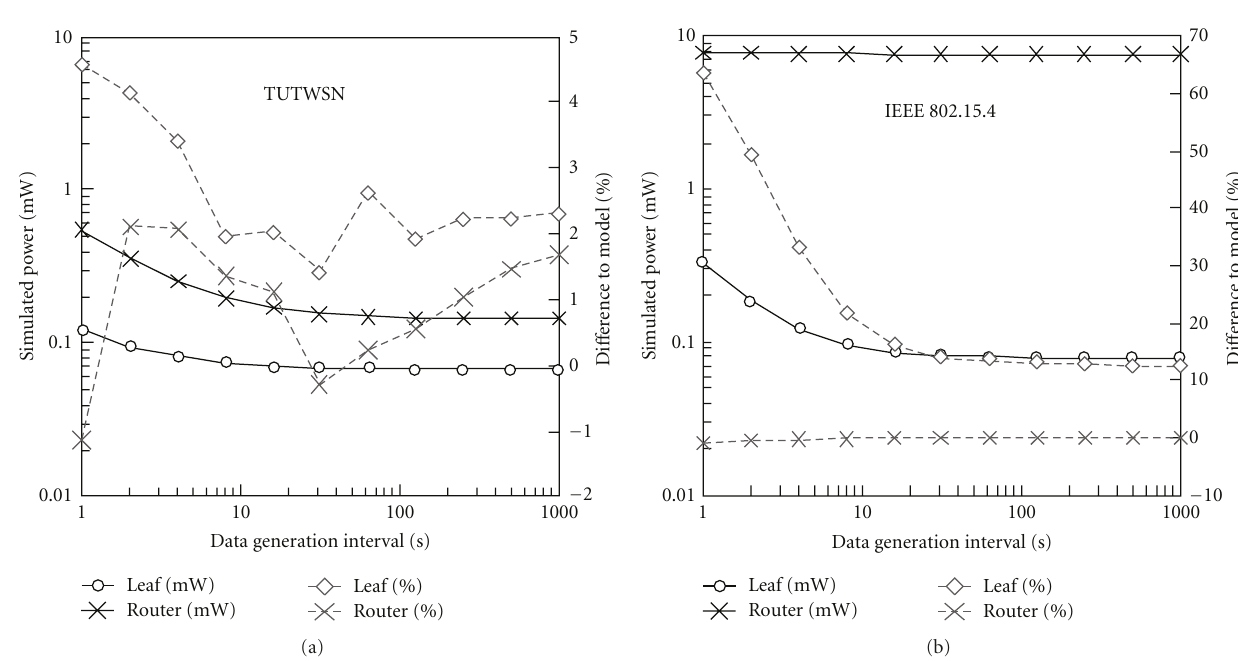
Figure 16: Di ff erence between simulated and modeled power consumptions in TUTWSN and IEEE 802.15.4.